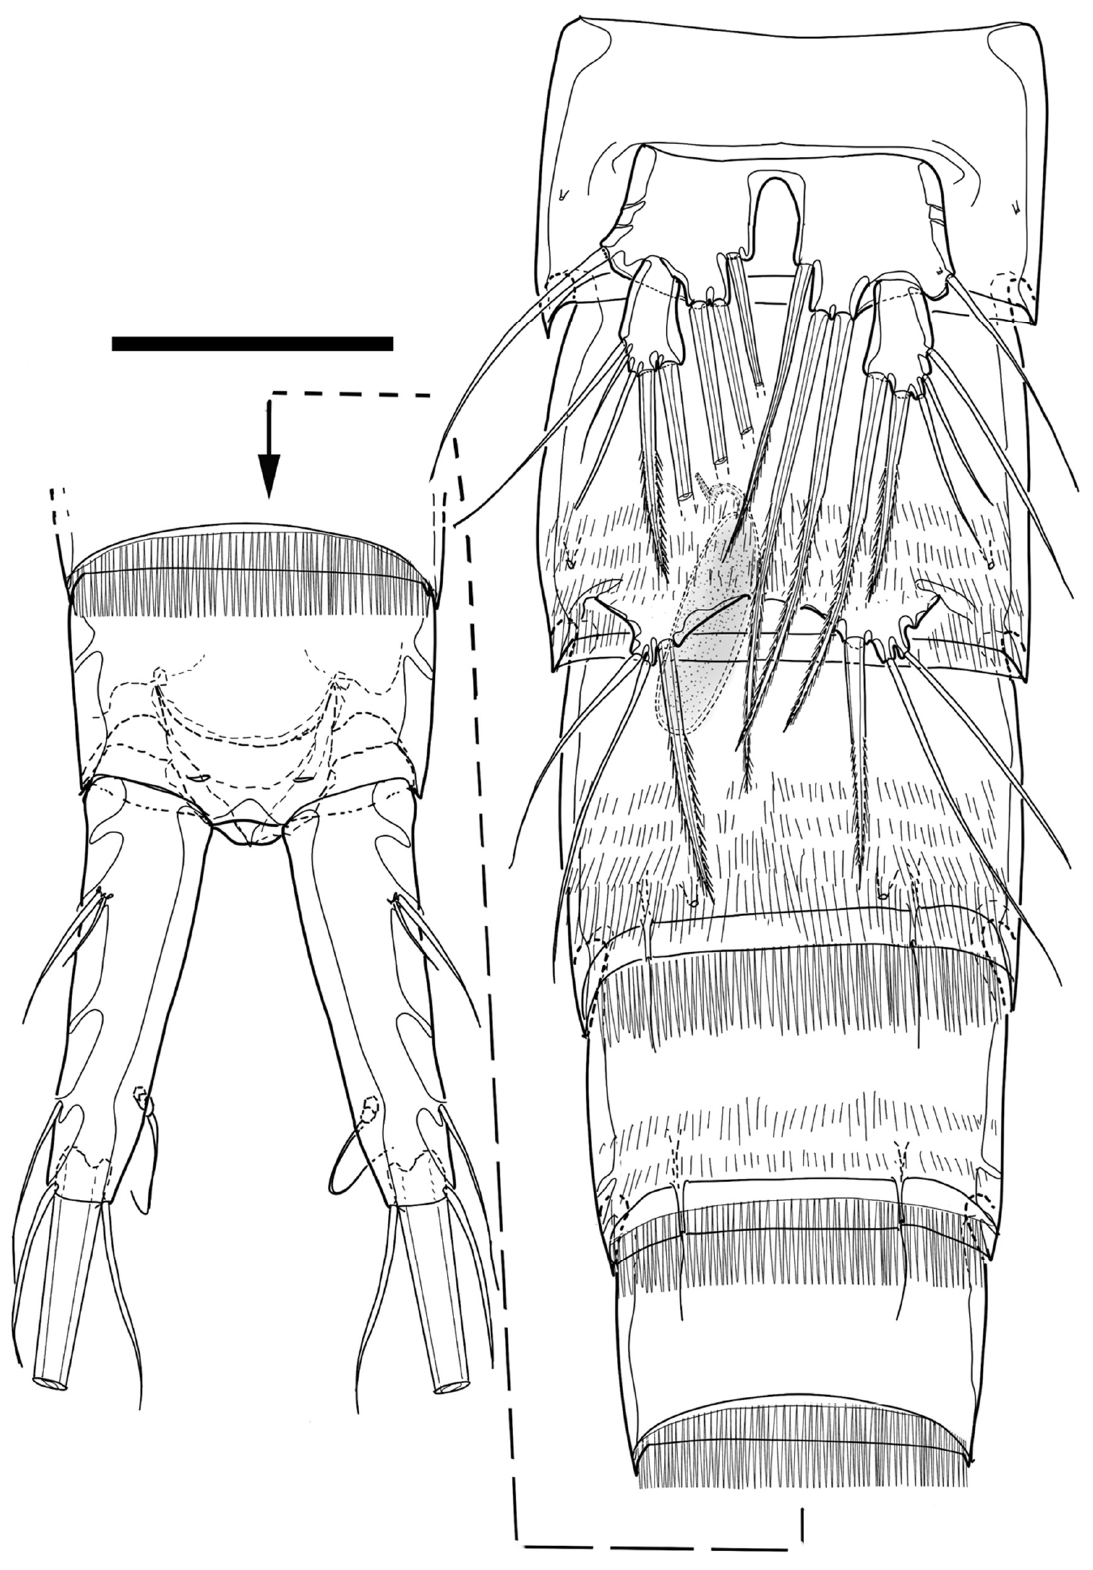
Figure 35. Line drawings of Phyllopodopsyllus similis sp. nov. male (paratype 25): urosomite, ventral. Scale bar: 50 µm.